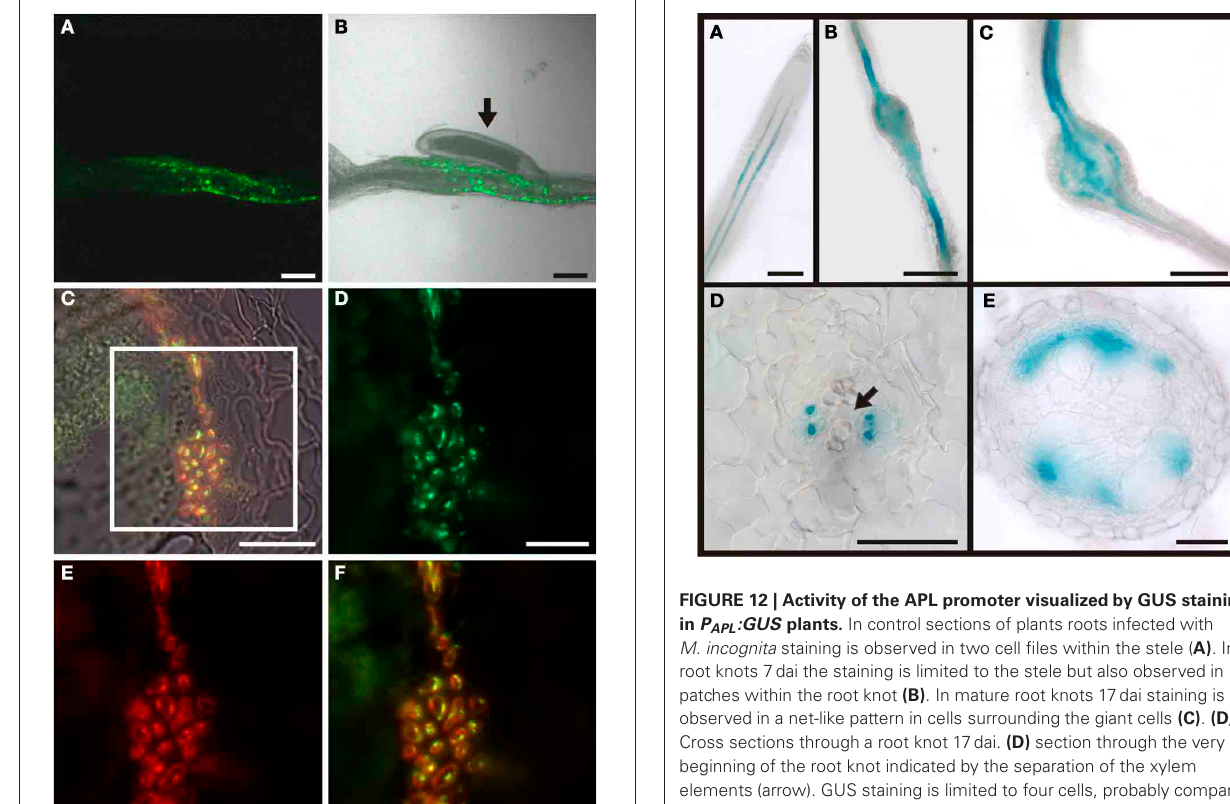
1 and 2 weeks after infection the cells change their identity.